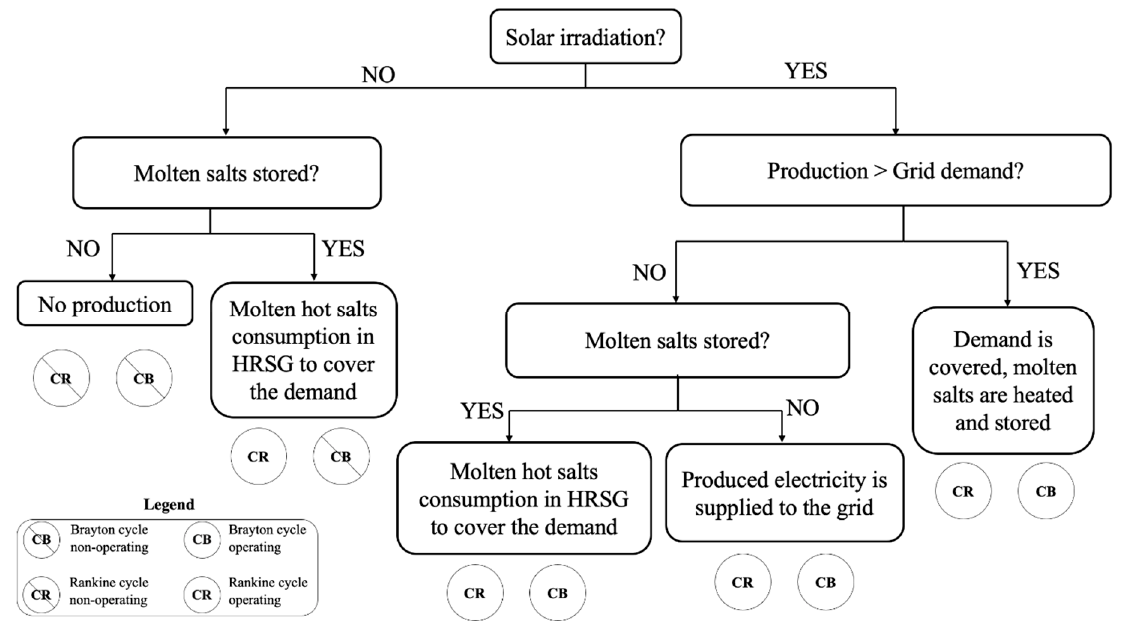
Figure 3. Operational and dispatch flow-chart of the ISCC power plant layout with thermal energy storage (TES) system.